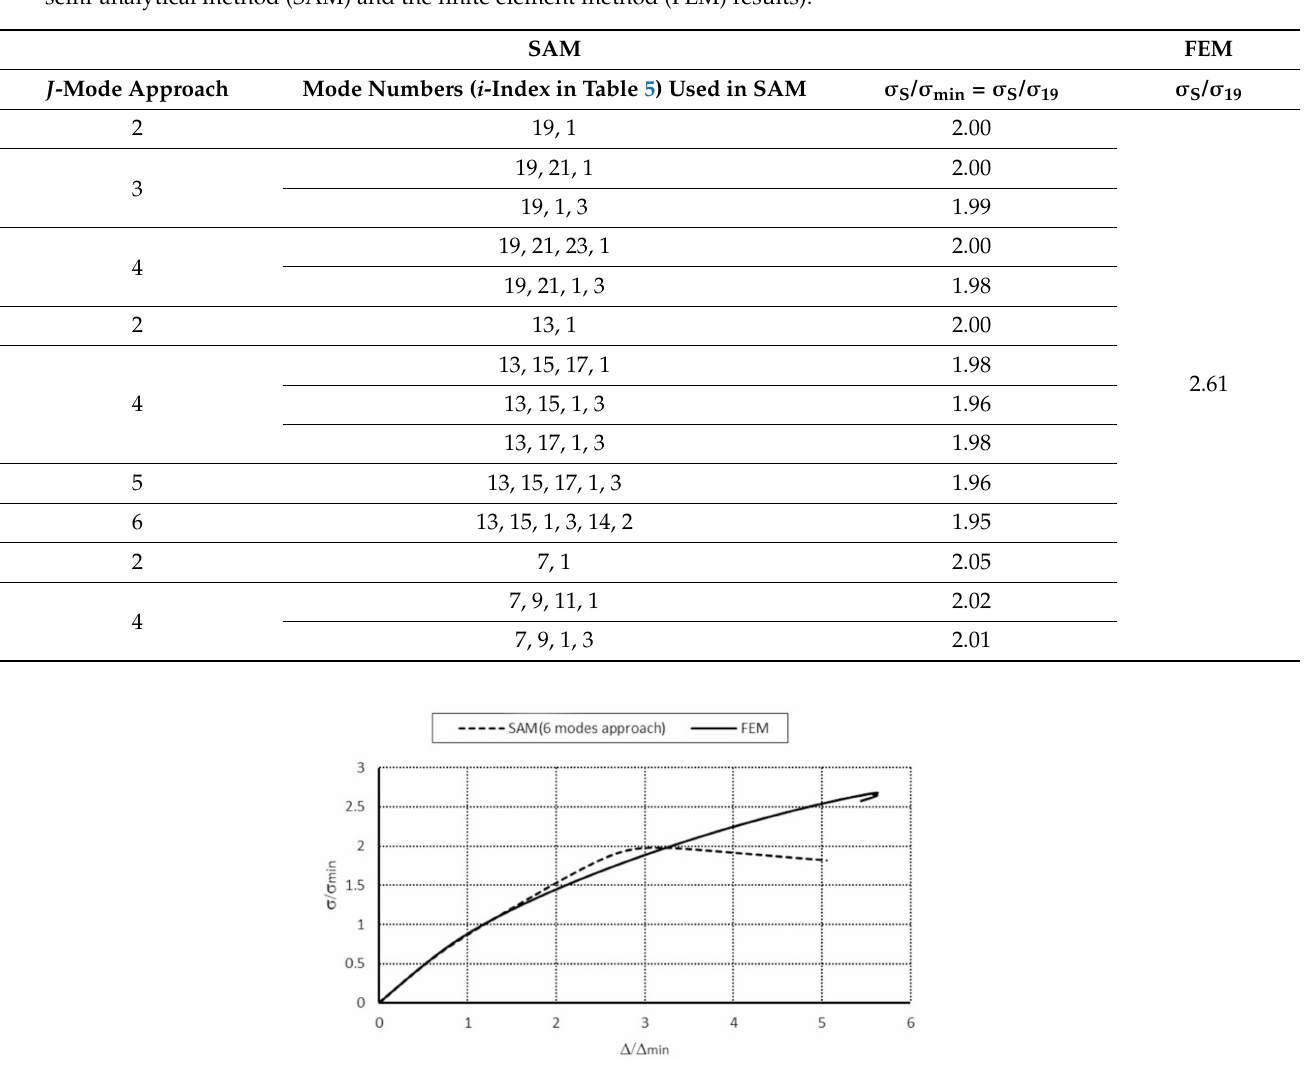
Figure 17. Dimensionless post-buckling equilibrium paths for the TH-channel of total length 225 mm.